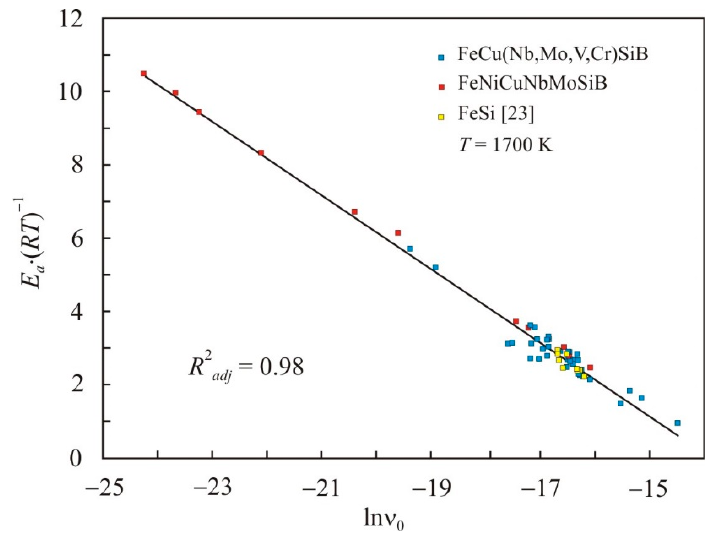
Figure 4. Relation of the reduced activation energy E a ·( RT ) − 1 with the pre-exponential factor in the natural logarithmic scale ln ν 0 for multicomponent FeCuNbSiB-based and binary Fe-Si melts at a temperature of 1700 K.